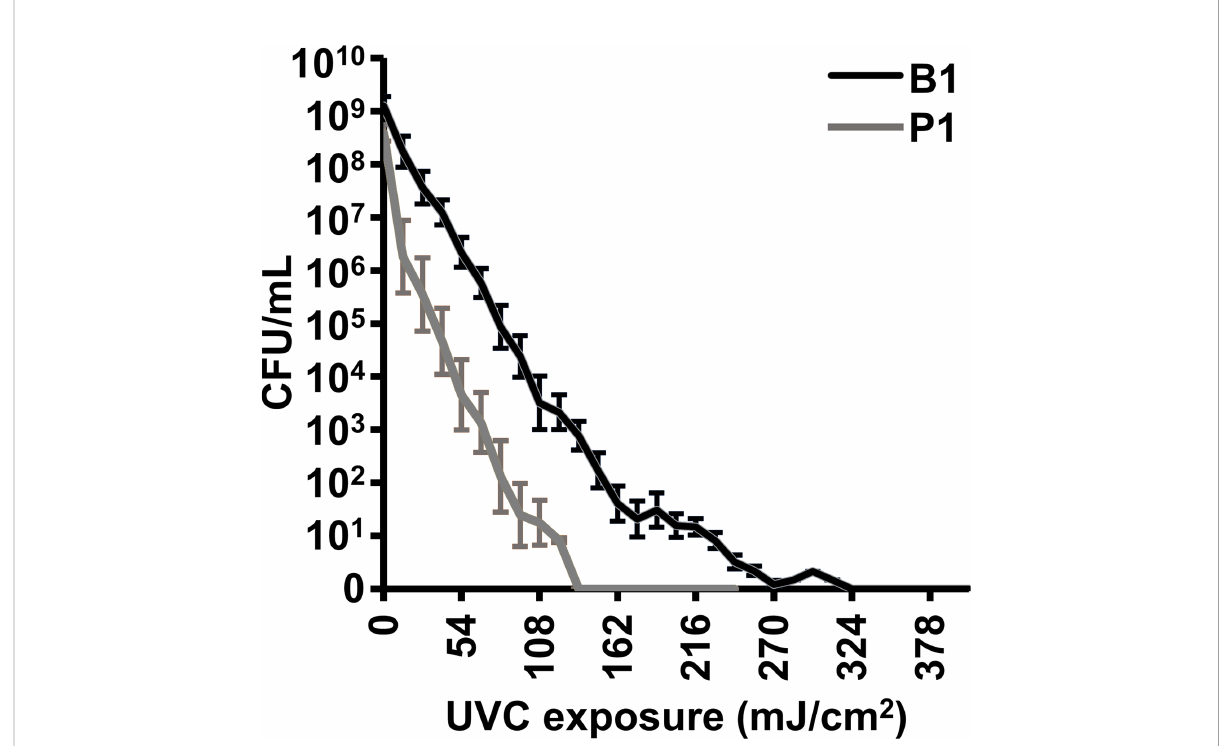
FIGURE 1 UVC inactivation of A. baumannii vaccine candidates B1 and P1. 0.1 mL volumes of bacterial cultures at approximately 1 x 10 9 CFU/mL were compounded with the MDP complex and exposed to UVC irradiation (4.5 mW/cm 2 ) for increasing times. Energy is shown in millijoules (mJ/ cm 2 ). The treated samples were serially diluted and plated to determine the concentration of live, colony-forming, bacteria. The experiment was done in triplicate and error bars show the standard error of the